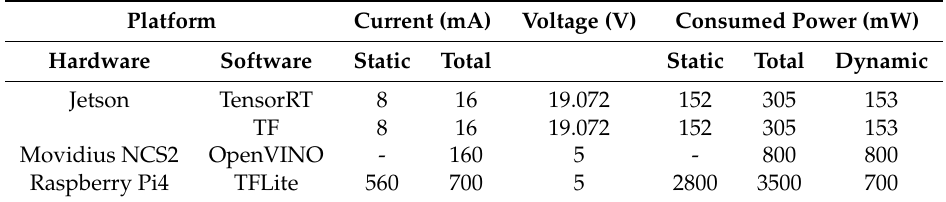
Table 4. Power consumption.